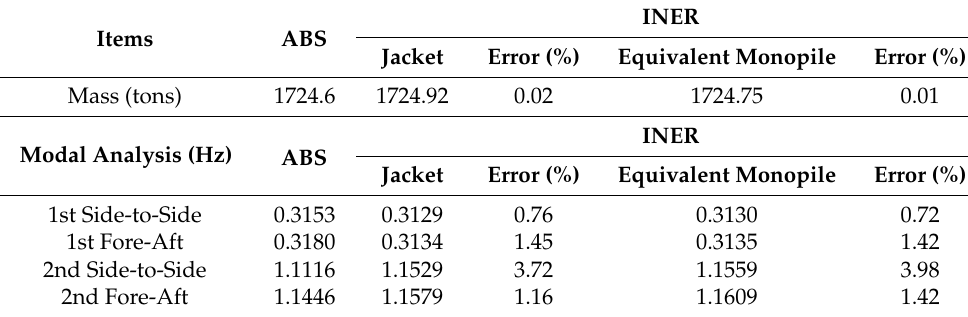
Table 2. Comparison of Model Properties.